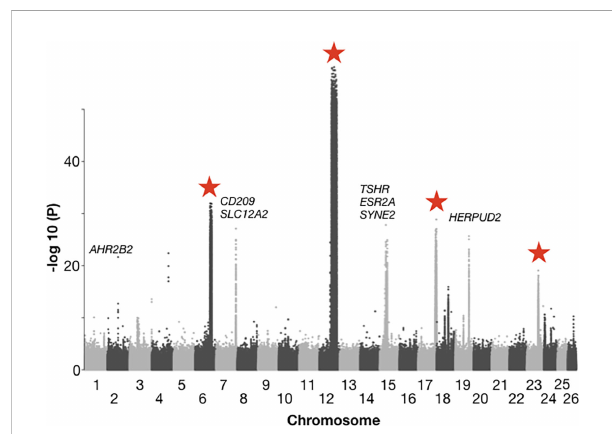
FIGURE 3 Genetic differentiation between herring populations from Ireland and Britain vs. other populations from the Northeast Atlantic. Inversions are located on chromosomes 6, 12, 17, and 23, and are highlighted with red stars. Strong genetic differentiation is observed in the following intervals: chromosome 6: 22.2 – 24.8 Mb, chromosome 12: 17.8 – 25.6 Mb, chromosome 17: 25.8 – 27.5 Mb, and chromosome 23: 16.3 – 17.5 Mb. The Y-axis represents -log10